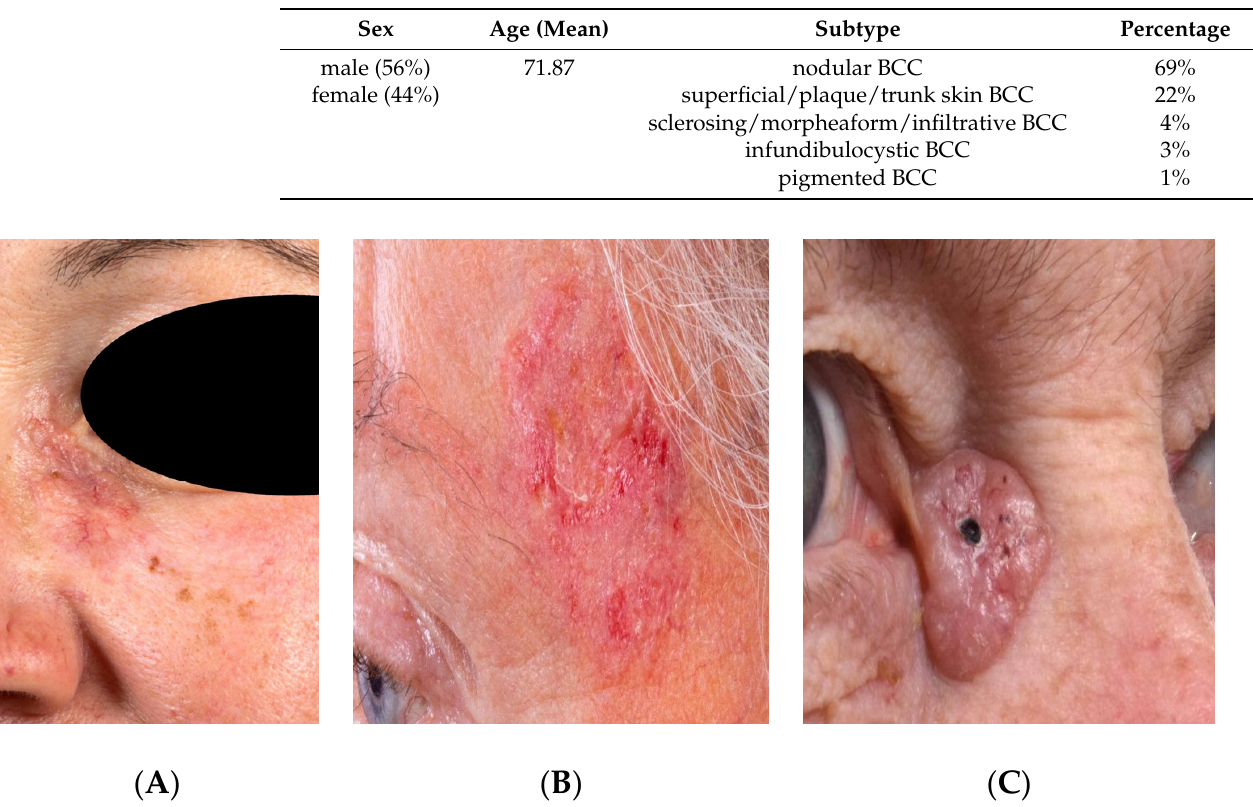
Figure 1. Clinical manifestation of basal cell carcinoma (BCC). ( A ): micronodular, ( B ): infiltrative, and ( C ): nodular histological types.